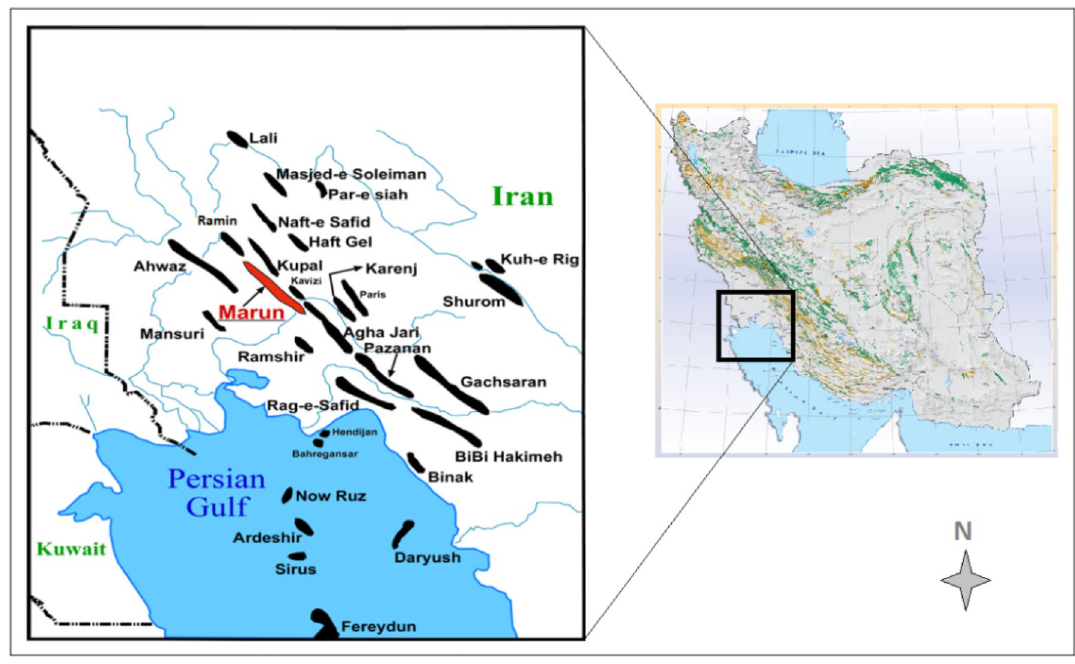
Fig. 1 Location of the oil field under study in central Zagros in the Dezful Embayment area (NIOC